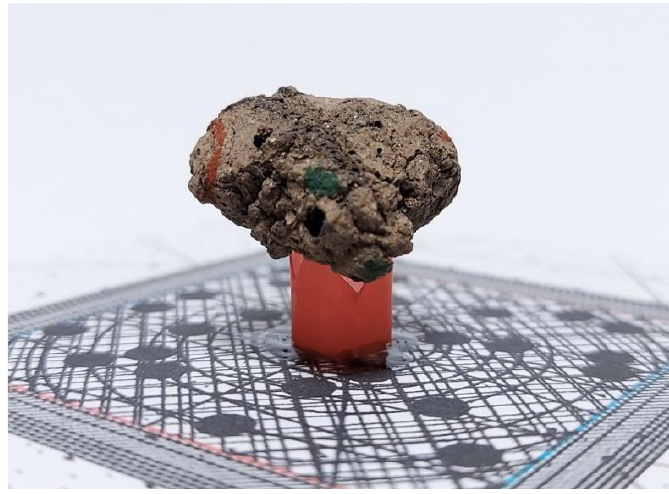
Figure 3. LECA prepared for image acquisition.